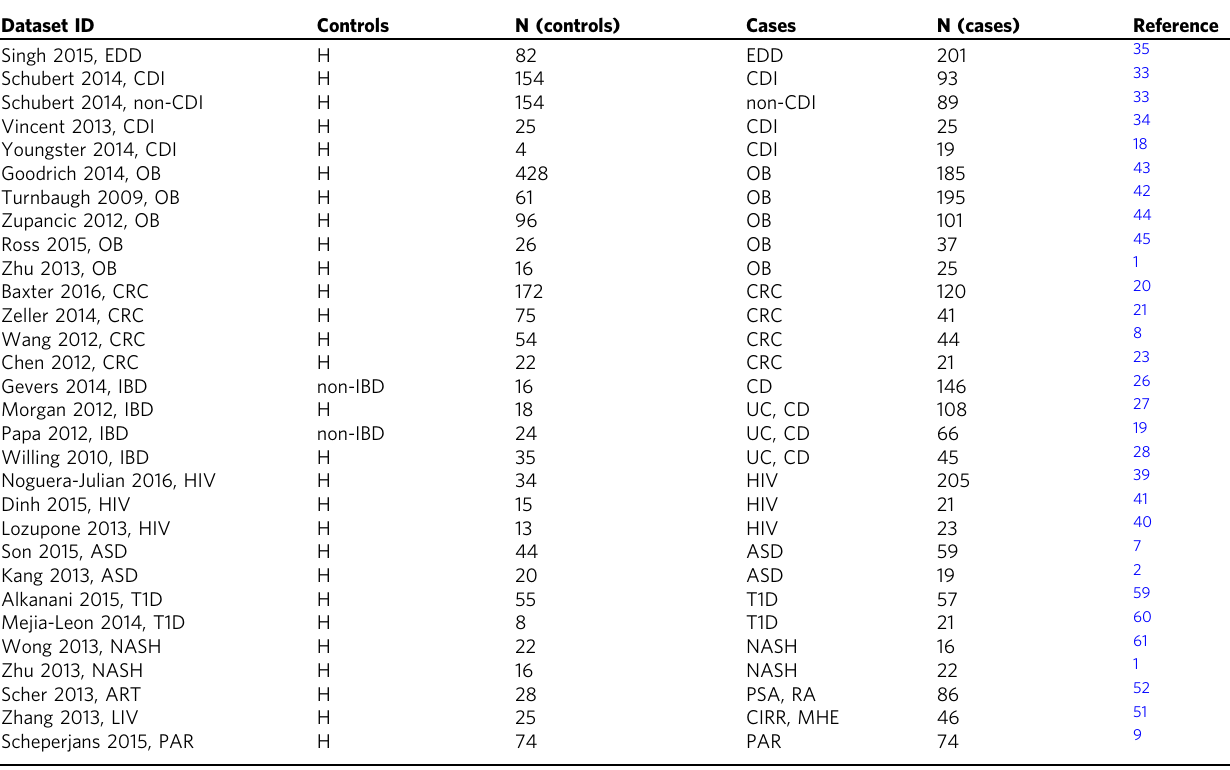
Non-CDI controls are patients with diarrhea who tested negative for C . dif fi cile infection. Non-IBD controls are patients with gastrointestinal symptoms but no intestinal in fl ammation. Data sets are ordered as in Fig. 1 ART arthritis, ASD autism spectrum disorder, CD Crohn ’ s disease, CDI Clostridium dif fi cile infection, CIRR liver cirrhosis, CRC colorectal cancer, EDD enteric diarrheal disease, H healthy, HIV human immunode fi ciencyvirus, LIV liverdiseases, MHE minimalhepaticencephalopathy, NASH non-alcoholicsteatohepatitis, OB obesity, PAR Parkinson ’ sdisease, PSA psoriaticarthritis, RA rheumatoidarthritis, T1D type I diabetes, UC ulcerative